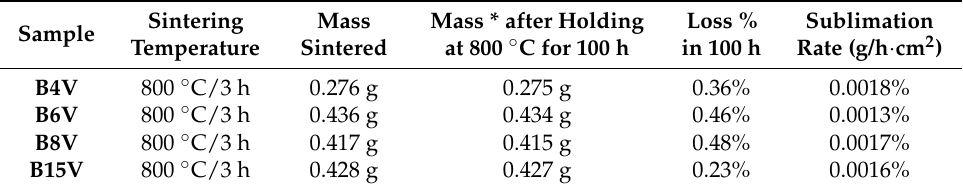
Table 1. Mass loss selected BxV compositions by different thermal annealing in air.